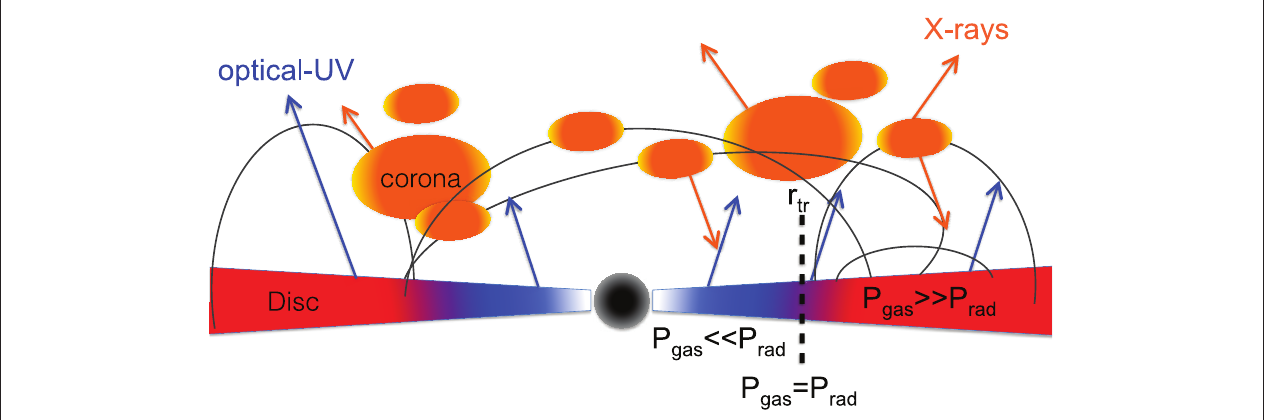
FIGURE 2 | A schematic representation of the toy model discussed in §3. The optically thick, geometrically thin accretion disc emits the seeds photons that illuminate the hot tenuous (possibly clumpy) plasma. A fraction of them is up-scattered to hard X-rays via inverse Compton scattering. Part of these hard X-ray photons is irradiated back to the disc, contributing to its energy balance, whilst the rest escape and are observed. Stable magnetic loop can be formed only in the radiation pressure dominated part of the disc.